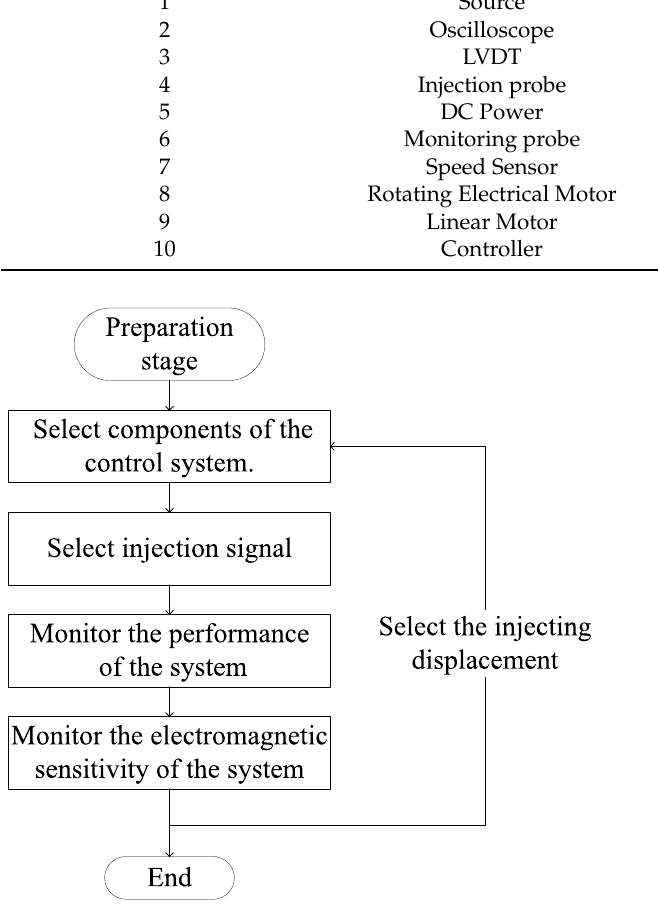
Figure 7. BCI test flow.